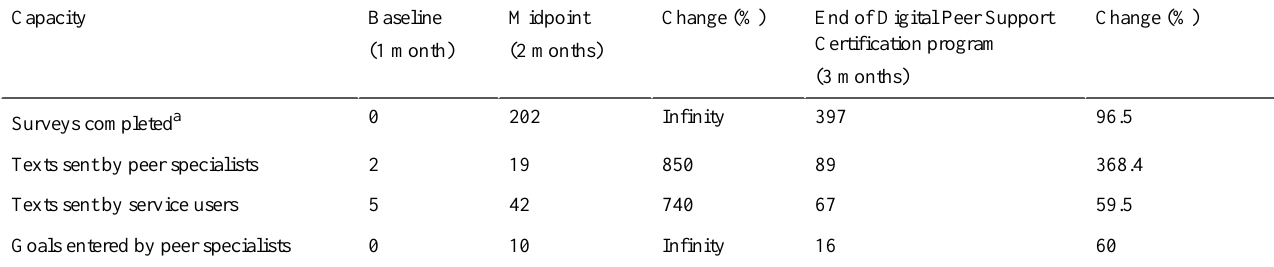
Table 1. Changes in peer support specialists’capacity to use digital peer support technology from baseline to the midpoint and end of the Digital Peer Support